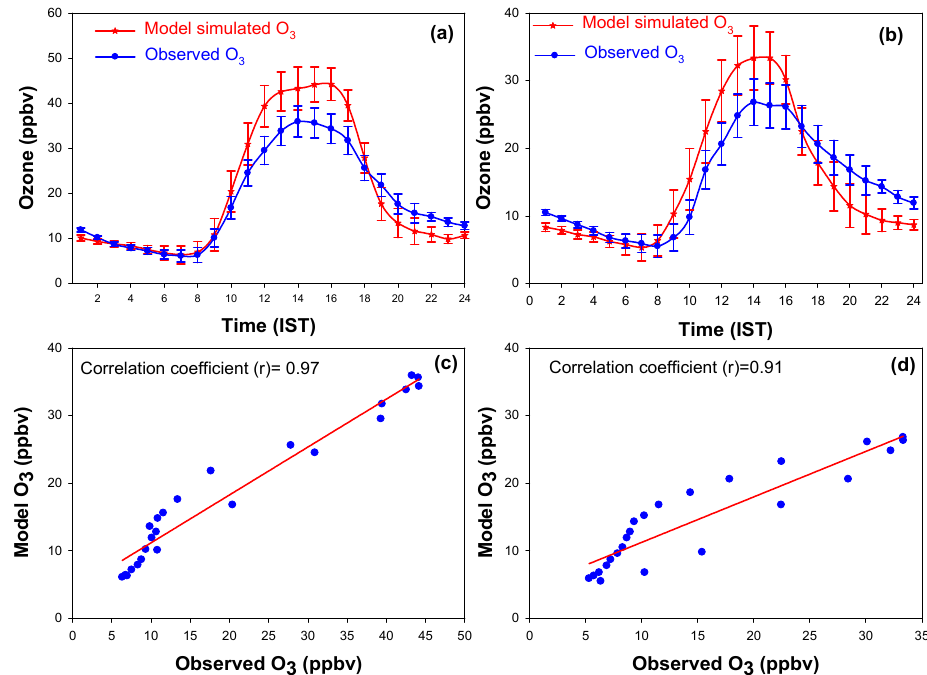
Figure 8. Diurnal variation of measured (averaged over the period 2013–2018) and modeled O 3 for ( a ) winter, ( b ) summer, ( c ) scatter plot showing the correlation between model O 3 and measured O 3 for winter, ( d ) summer.